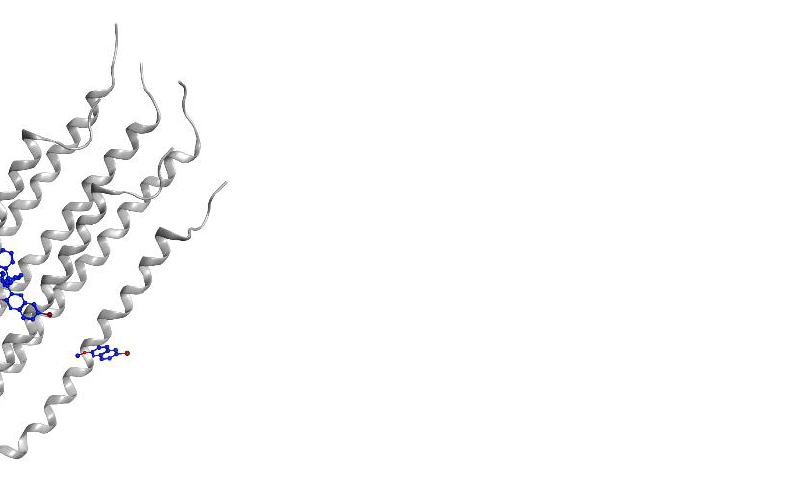
Figure 6. Bedaquiline (blue) in mycobacterial ATP synthase subunit C (gray ribbon) (PDBID: 4V1F).